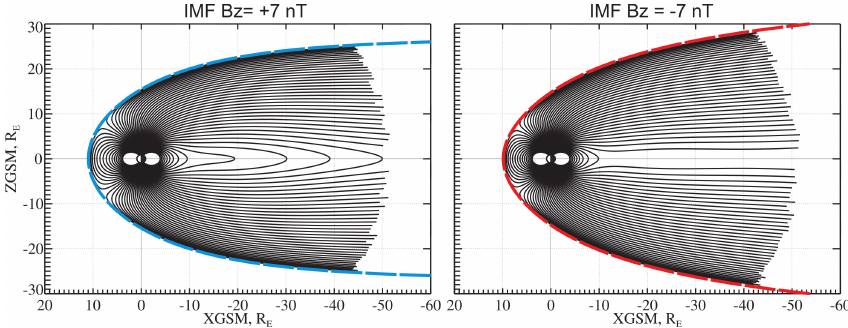
Fig. 18. Illustrating the effect of the magnetopause flaring rate on the distant tail configuration in the T13 model. Larger flaring due to negative IMF B z results in more stretched field lines.